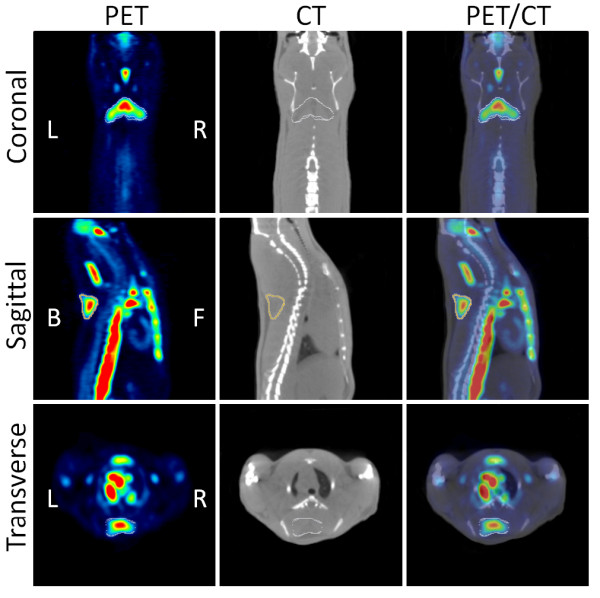
Coronal, sagittal, and transverse views of PET/CT images. The images show how automatic contour VOIs were drawn on the CL316,243-activated BATs: PET (left), CT (middle), and fused PET/CT (right).